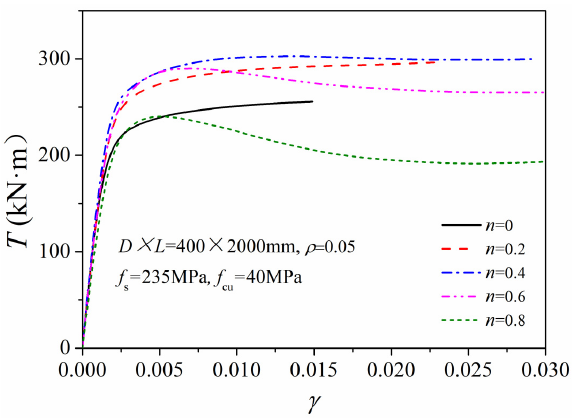
Figure 4. N – ε L relationship of the compression-torsion columns.